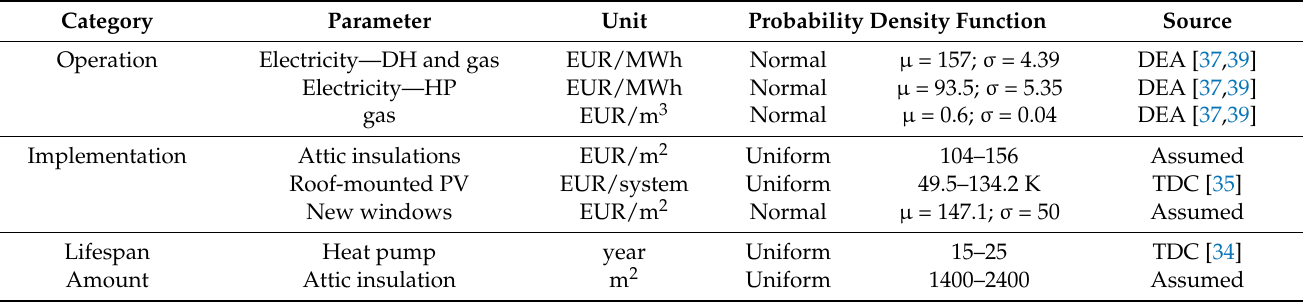
Table 3. Summary of variation parameters applied in Monte Carlo method.